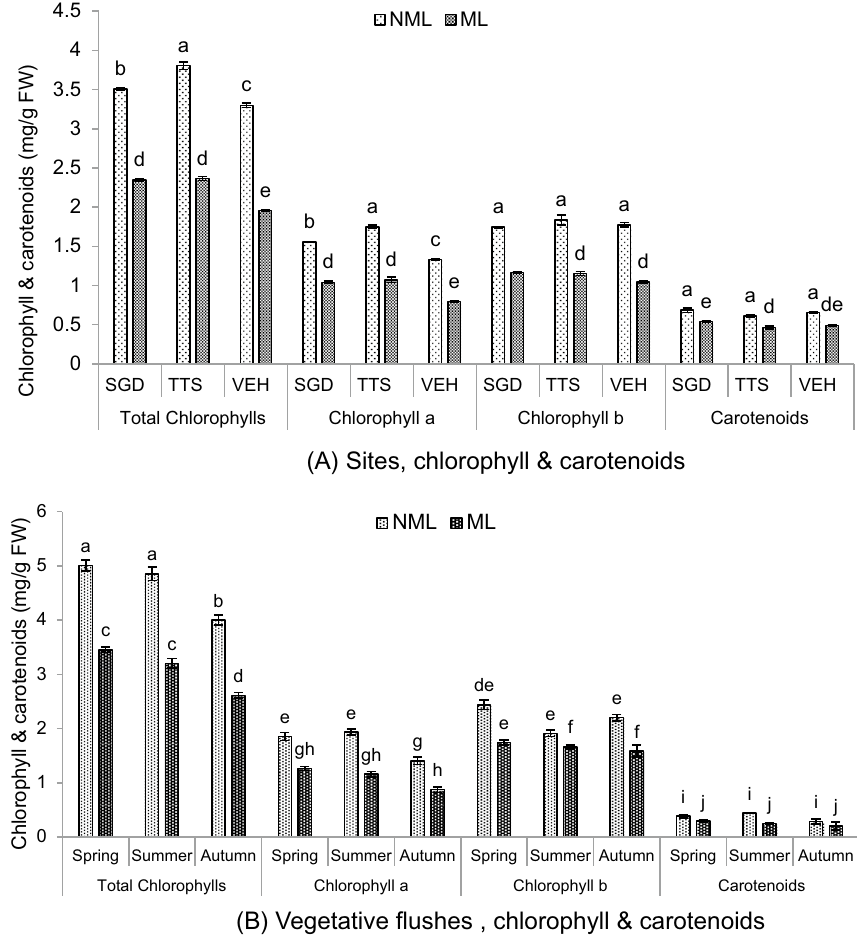
Figure 4. Chlorophylls and carotenoid contents of non-mined and mined leaves ( A ) different environmental conditions ( B ) three vegetative flushes. Bars sharing dissimilar letters are significantly differed according to LSD test ( P ≤ 0.05). FW = fresh weight.